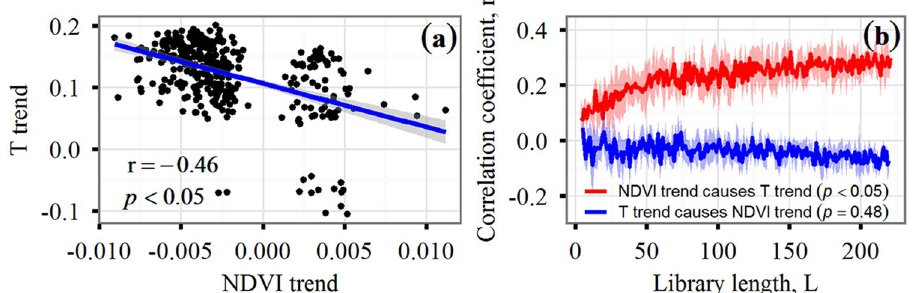
Figure 2. The linear regression ( a ) and convergent cross mapping (CCM) causality ( b ) relationship between the linear trend of the NDVI (NDVI trend ) and temperature (T trend ). Shadows on either side of the CCM curves represent ± standard error. The library length, L, is the number of observations (pixels with significant trend ( p < 0.05) for NDVI or temperature). The NDVI trend -reconstructed T trend gradually converges to a large positive correlation coefficient (r = 0.35) whereas the T trend -reconstructed NDVI trend displays flat curves with a low correlation coefficient, suggesting that the NDVI trend has a significant unidirectional causality relationship with the T trend .